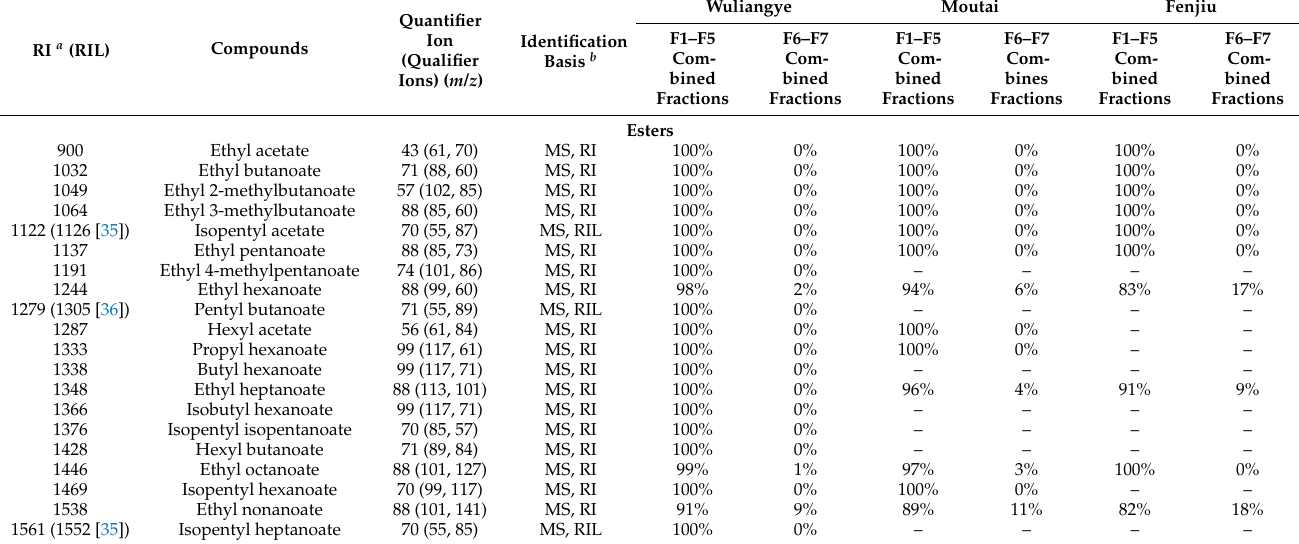
Table 4. Three baijiu volatile distributions in F1–F5 and F6–F7 (as the percentage of the total elution amount).